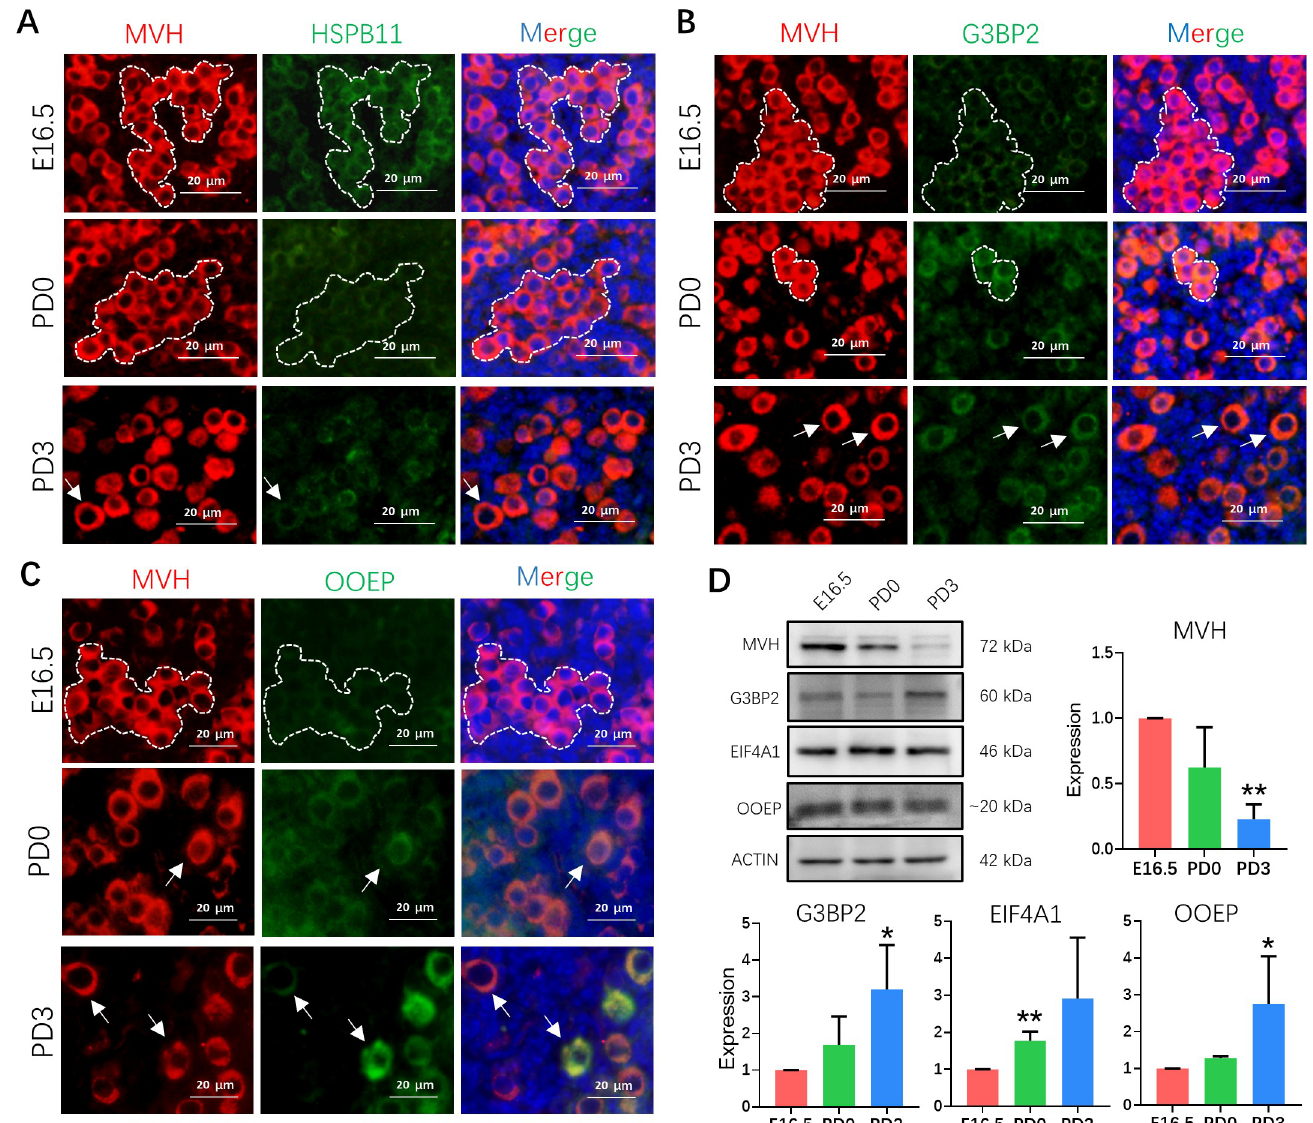
Fig 3. Marker gene detection of germ cells at pre-, early- and late-follicle formation stages. ( A ) Representative images of the HSPB11 staining of ovarian sections from E16.5 embryos, and PD0 and PD3 pups. Germ cells were marked by MVH (red); HSPB11 was stained with green; and nucleus was counterstained with Hoechst 33342 (blue). Dotted white line label the germline nest and white arrow mark the germ cell in follicle. Scale bar: 20 μ m. ( B ) Representative images of the G3BP2 of ovarian sections from E16.5 embryos, and PD0 and PD3 pups. Germ cells were marked by MVH (red); G3BP2 was stained with green; and nucleus was counterstained with Hoechst 33342 (blue). Dotted white line label the germline nest and white arrow mark the germ cell in follicle. Scale bar: 20 μ m. ( C ) Representative images of the OOEP staining of ovary sections from E16.5 embryos, and PD0 and PD3 pups. Germ cells were marked by MVH (red), OOEP was stained with green and nucleus was counterstained with Hoechst 33342 (blue). Dotted white line label the germline nest and white arrow mark the germ cell in follicle. Scale bar: 20 μ m. ( D ) Detection of G3BP2, EIF4A1, OOEP, ACTIN, and MVH proteins of E16.5 embryos, and PD0 and PD3 pups by western blot. ACTIN (only for MVH expression), and MVH was used as a loading control. Data were represented with mean ± SD ( n = 3 for independent repeats). The relative expression level was calculated between PD0 or PD3 and E16.5. Unpaired t tests are performed. Statistical significance is shown as � P < 0.05; �� P < 0.01. The raw data image can be found in S1 Data. The raw data used for quantification of D can be found in S2 Data. EIF4A1, eukaryotic translation initiation factor 4A1; E16.5, embryonic day 16.5; G3BP2, GTPase-activating protein-binding protein 2; HSPB11, heat shock protein family B member 11; MVH, mouse vasa homologue; OOEP, oocyte expressed protein; PD0, postnatal day 0; PD3, postnatal day 3.